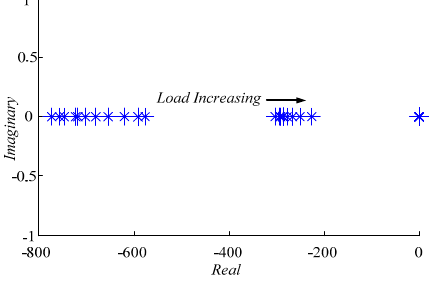
Figure 6. Root locus as the load resistance increases from 50 Ω to 100 Ω .